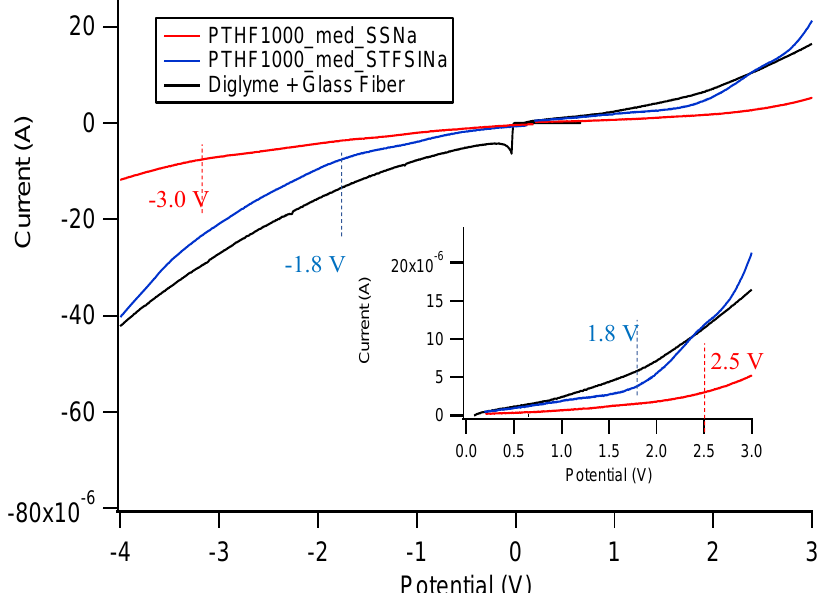
Figure A33. Oxidative and reductive stability of diglyme and diglyme gelled Na exchanged SIPEs. Configuration is stainless steel/Pt.